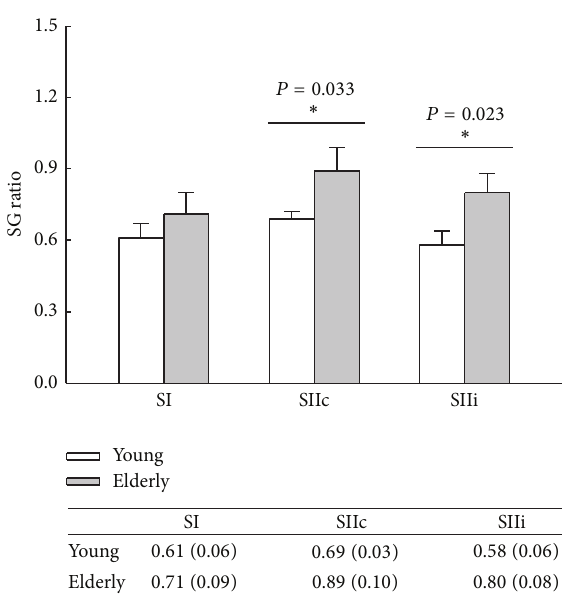
Figure 2: The statistical comparisons between young and elderly individuals in terms of sensory gating (SG) ratio in SI, SIIc, and SIIi areas. The bar above each column indicates the standard error of the mean (SEM).